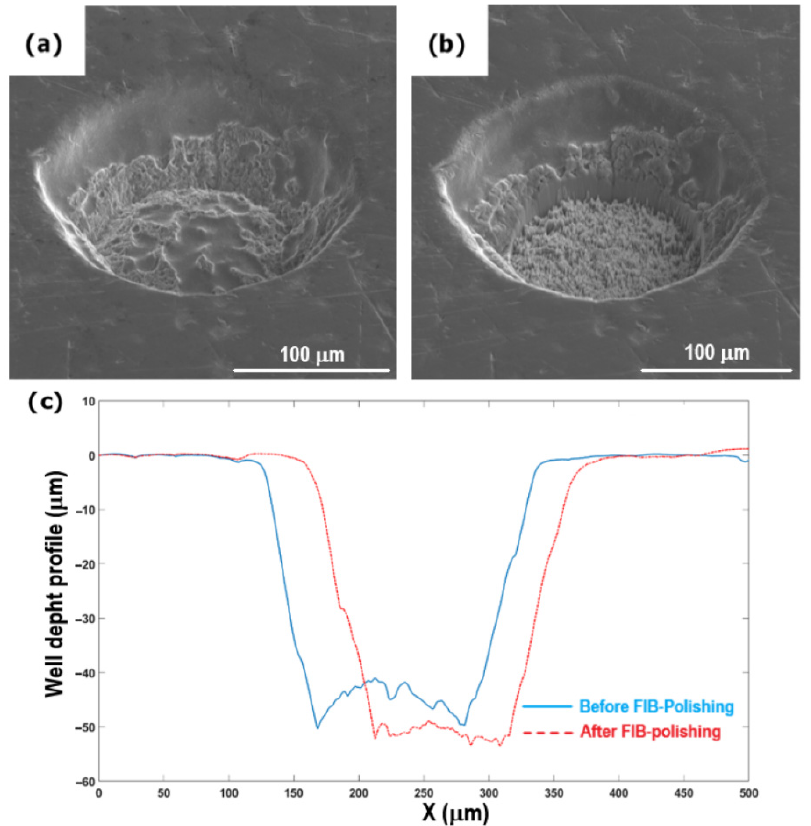
Figure 8 . Cross-sectional SEM images (tilt angle θ = 52°) showing a comparison of ( a ) before- and ( b ) after-FIB polishing on a single DS membrane. ( c ) Depth profiles of the same DS membrane before- and after-FIB polishing.